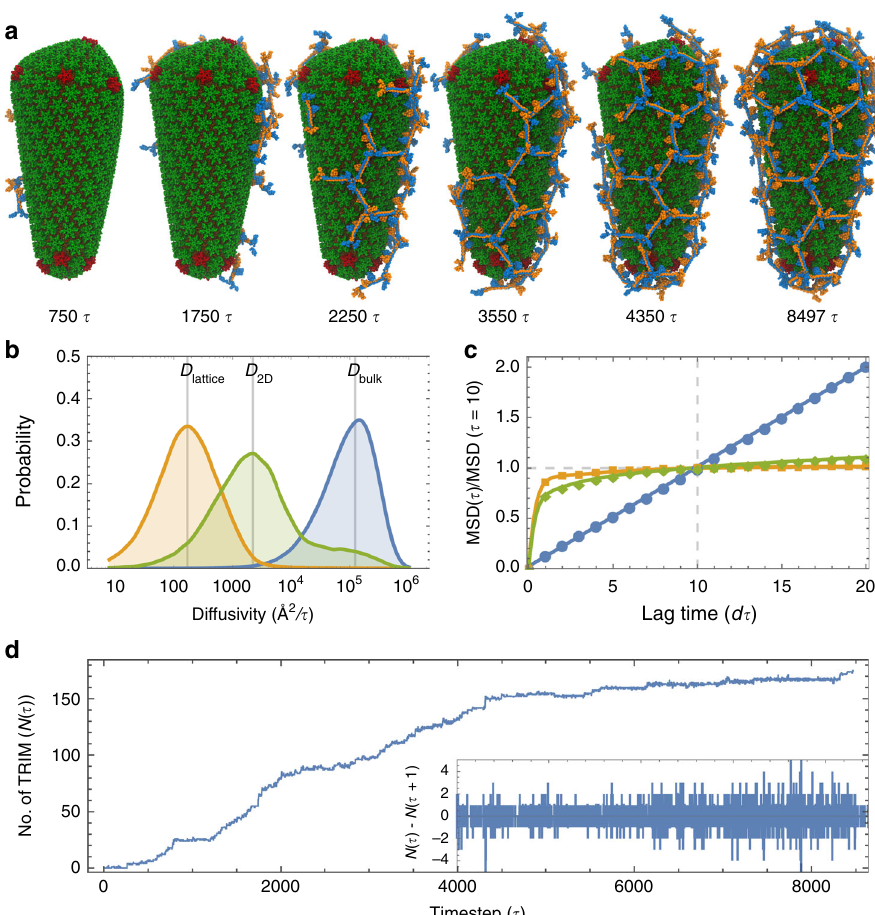
Fig. 2 Coupled TRIM5 α self-assembly and capsid binding. a The assembly process of TRIM5 α shows how TRIM5 α encages the viral capsid. Time points ( τ ) are given relative to the start of the simulation. b Normalized distribution of diffusivity values for TRIM5 α dimers in bulk solvent (blue; D bulk = 123,315 Å 2 / τ ), TRIM5 α dimers bound to the capsid surface (green; D 2D = 2224 Å 2 / τ ), and TRIM5 α lattices bound to the capsid (orange; D lattice = 174 Å 2 / τ ). c Mean-squared displacements (MSD) of the TRIM5 α subunits as a function of the lag time in units of τ . The MSD( t ) values were normalized by the MSD ( t = 10 τ ). Line colors correspond to the populations denoted in b . d Growth in the number of TRIM5 α subunits that form lattice contacts with other TRIM5 α , on the capsid surface, N ( τ ), as a function of time, τ . Inset shows the fi nite difference of N ( τ ) for t = 4000 – 8000 τ . Positive values indicate that lattice contacts form, whereas negative values indicate that lattice contacts break. Note that all units of time are given in τ = 250,000 CG simulation time